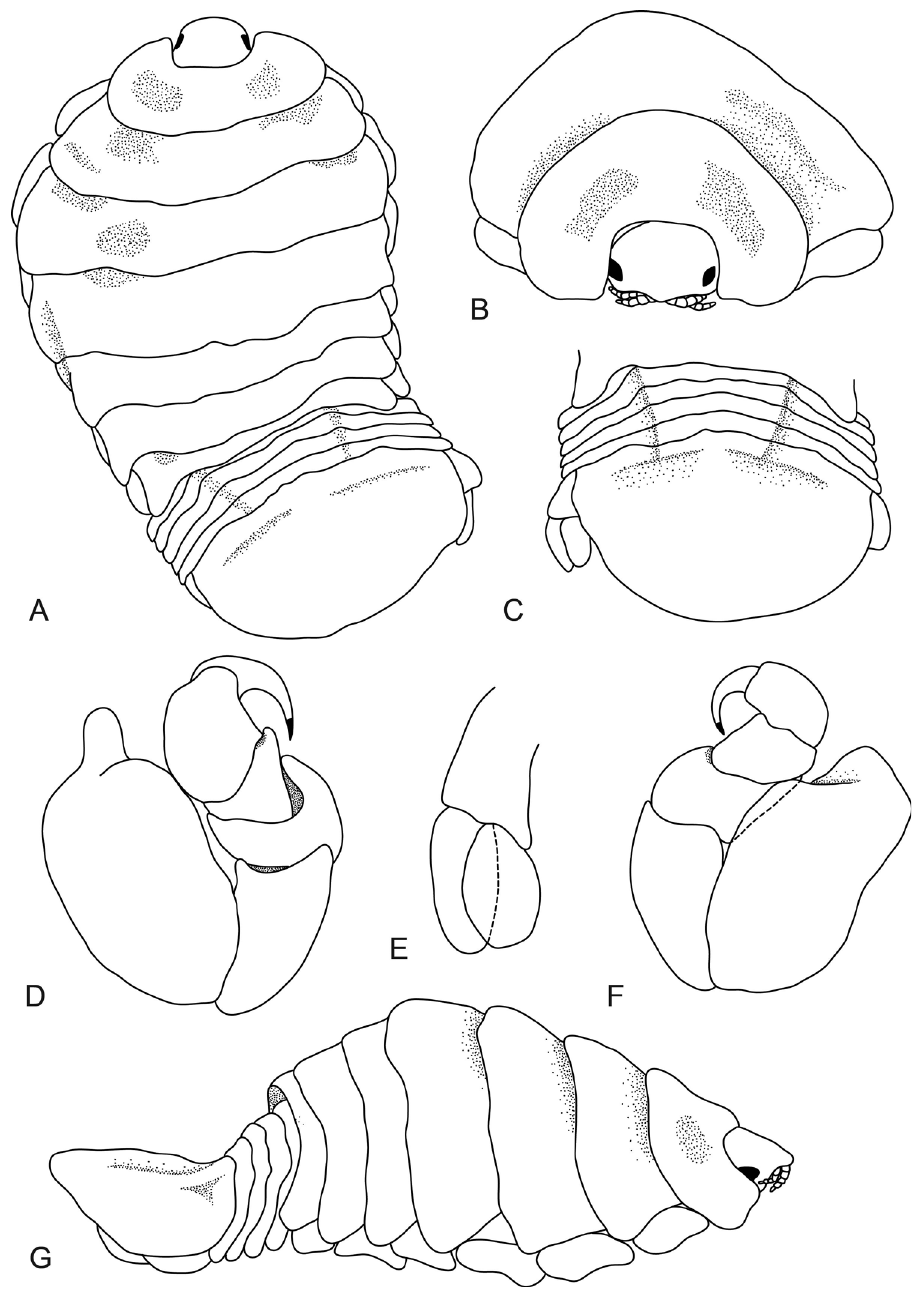
Figure 1. Elthusa winstoni sp. n., female holotype (17.5 mm) (AMNH_IZC 250217). A dorsal view B anterior view of pereonite 1, 2 and cephalon C dorsal view of pleotelson D pereopod 1 E uropod F pereopod 7 G lateral